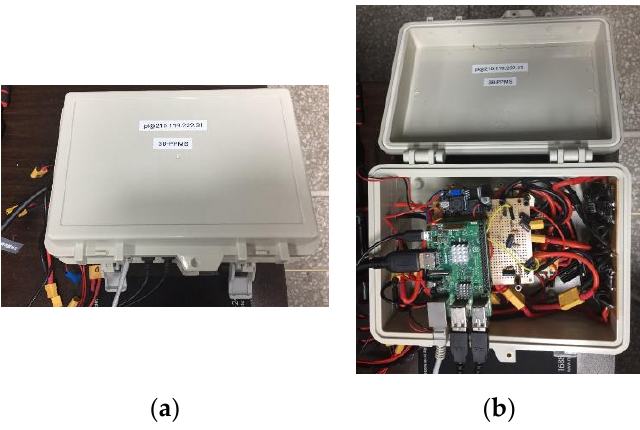
Figure 2. Overview of the HPC: ( a ) outside and ( b ) inside.